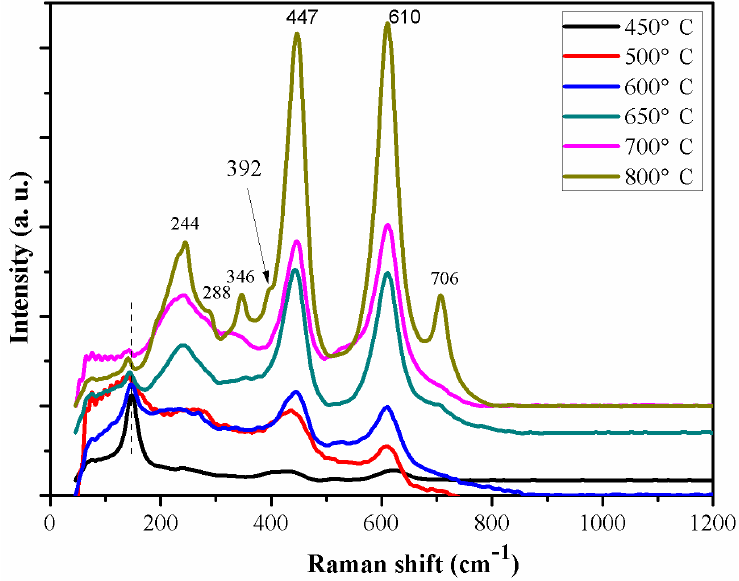
Figure 6. Raman shift of Ti-Ni-O samples annealed at different